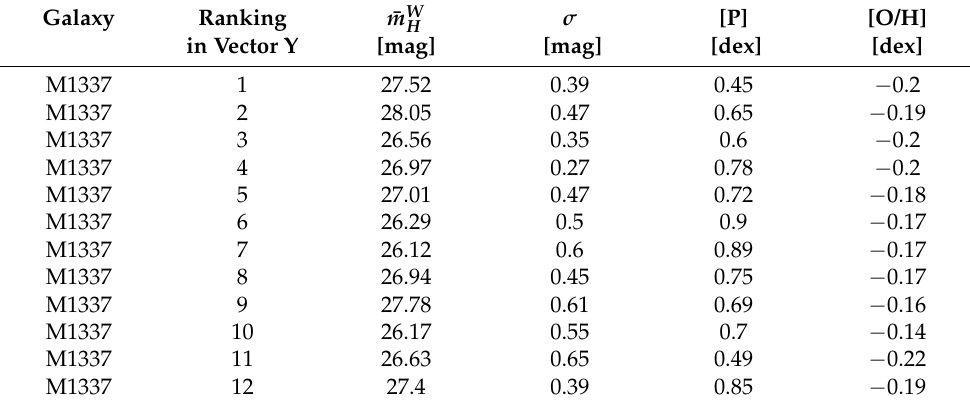
Table A3. Data for 3130 Cepheids in the host SnIa host galaxies and in the anchor or supporting galaxies N4258, M31, LMC, SMC from fits files in R21. An electronic version of the complete